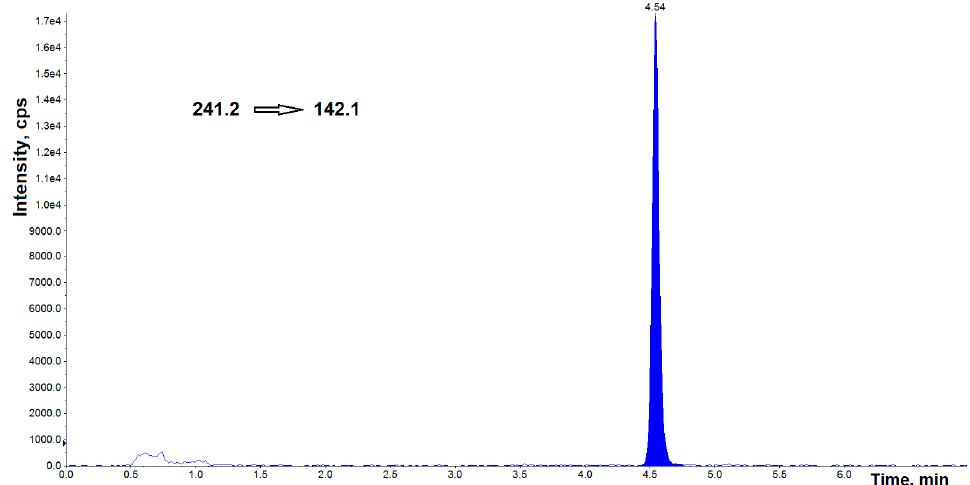
Figure 3. UHPLC–MS/MS chromatogram of bisphenol A-d 16 (IS) at concentration of 2.5 ng mL − 1 . cps—counts per second.